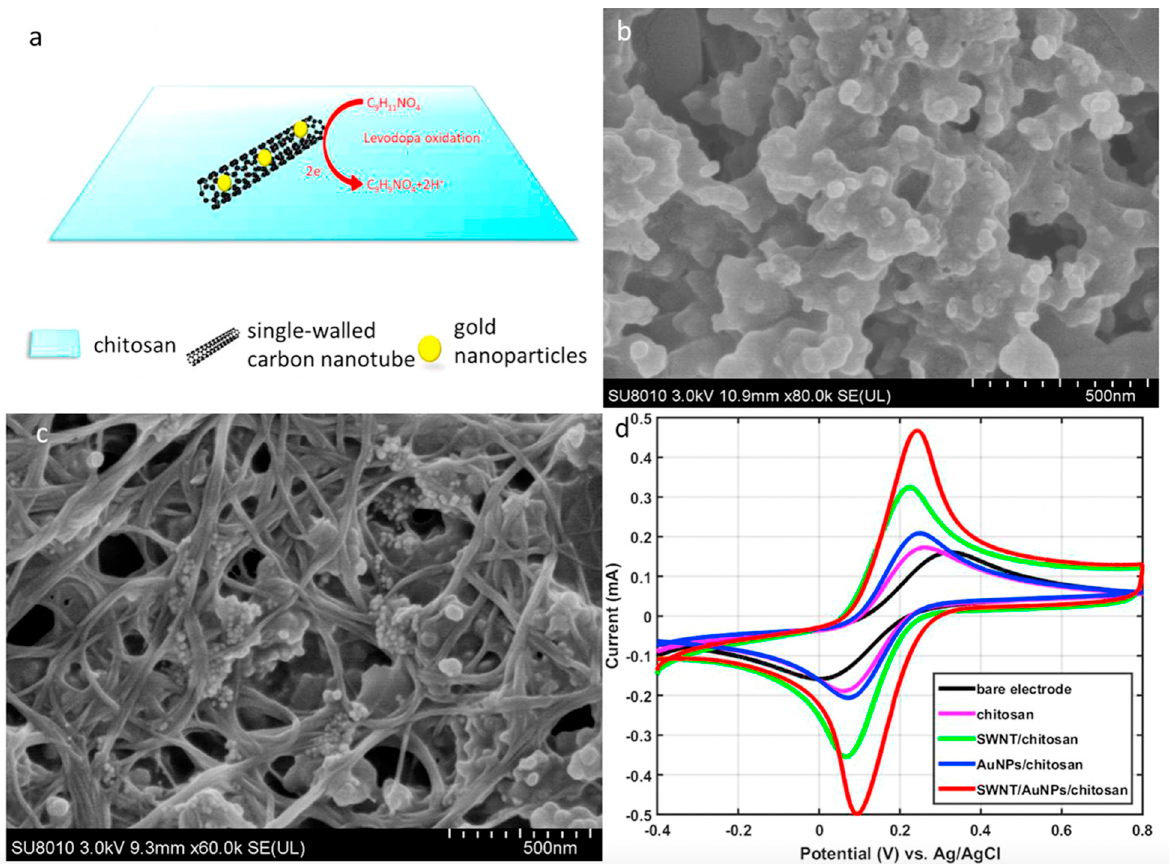
Figure 5. ( a ) Oxidation of levodopa on the surface of the modified working electrode. ( b ) The scanning electron microscope image of the bare screen-printed electrode. ( c ) The scanning electron microscope image of the gold nanoparticle/single-wall carbon nanotube/chitosan-film on the screen- printed electrode. ( d ) Cyclic voltammetry of the redox couple at different electrodes. Reprinted with permission from Biosensors and Bioelectronics, Copyright 2019, Elsevier [27].